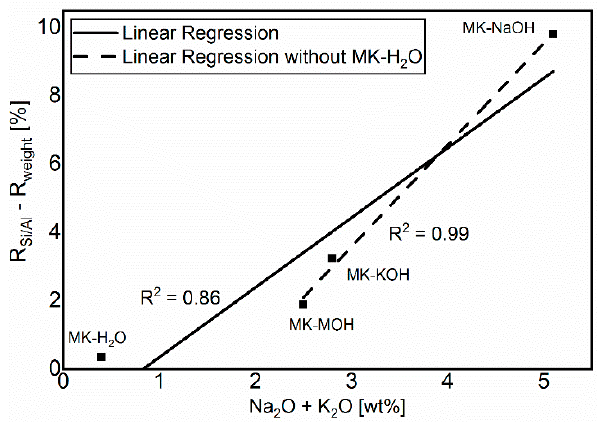
Figure 9. Correlation between the sum of alkalis and the difference of the calculated degrees of